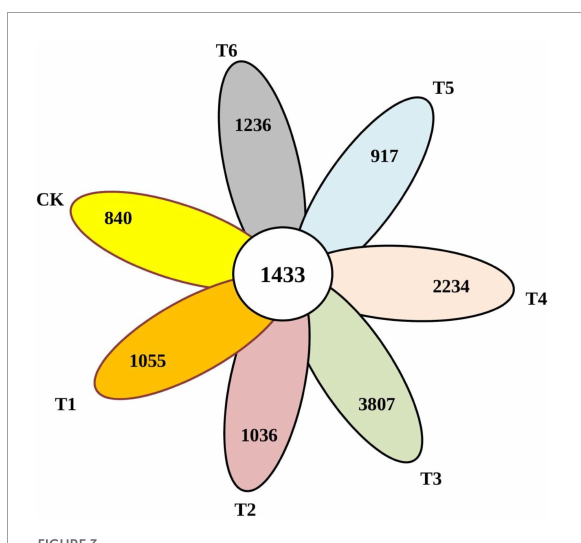
FIGURE3 Venn map of common and endemic species in the